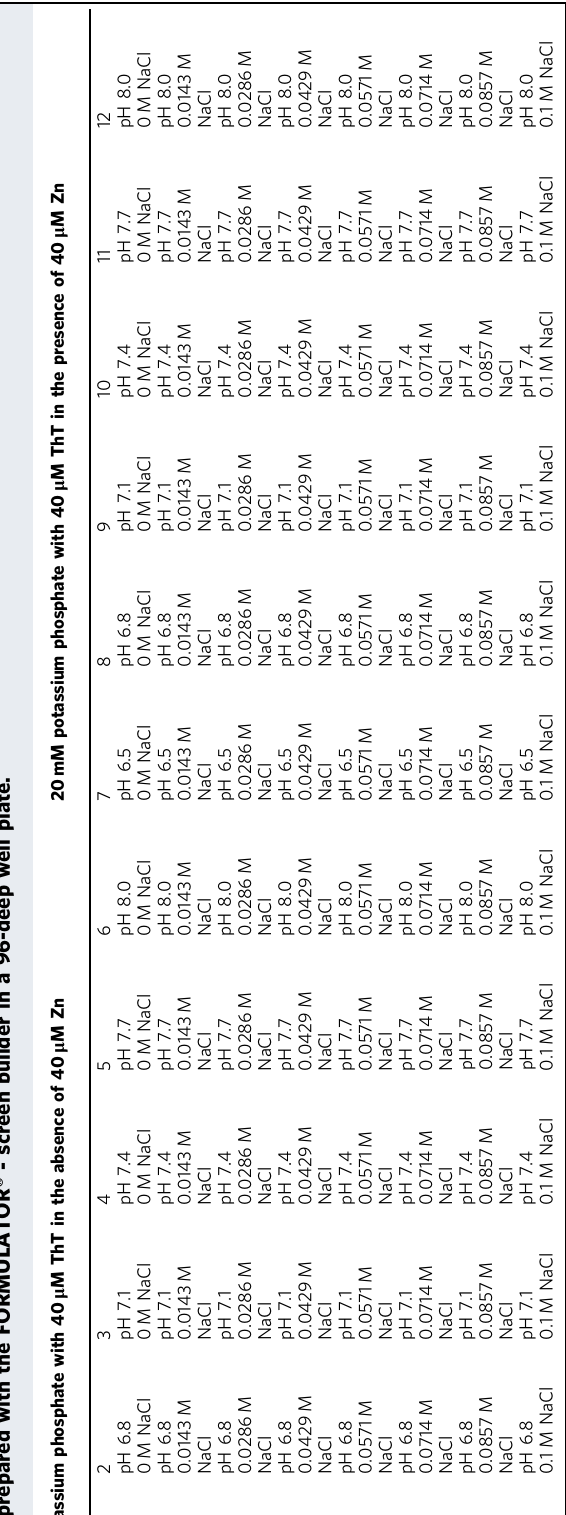
Figure 2 further con fi rmed the effect of Zn 2 + ions on the curves of A β 40 fi brillation. In addition, Fig. 2 con fi rmed that under different conditions with varied combinations of micro- environmental constituents, only one constituent affect A β 40 fi brillation completely, as shown in Fig. S1. In summary, A β 40 fi brillation behaves differently under